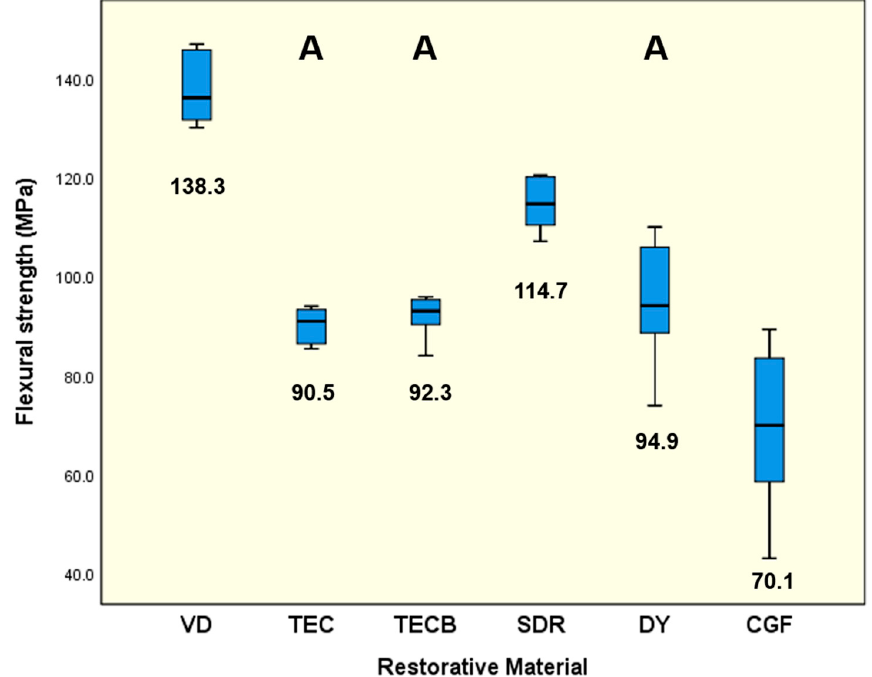
Figure 2. Flexural strength (MPa). Numerical values below each boxplot represent the calculated means. Identical uppercase letters denote no significant difference among calculated means of restorative materials ( p > 0.05).